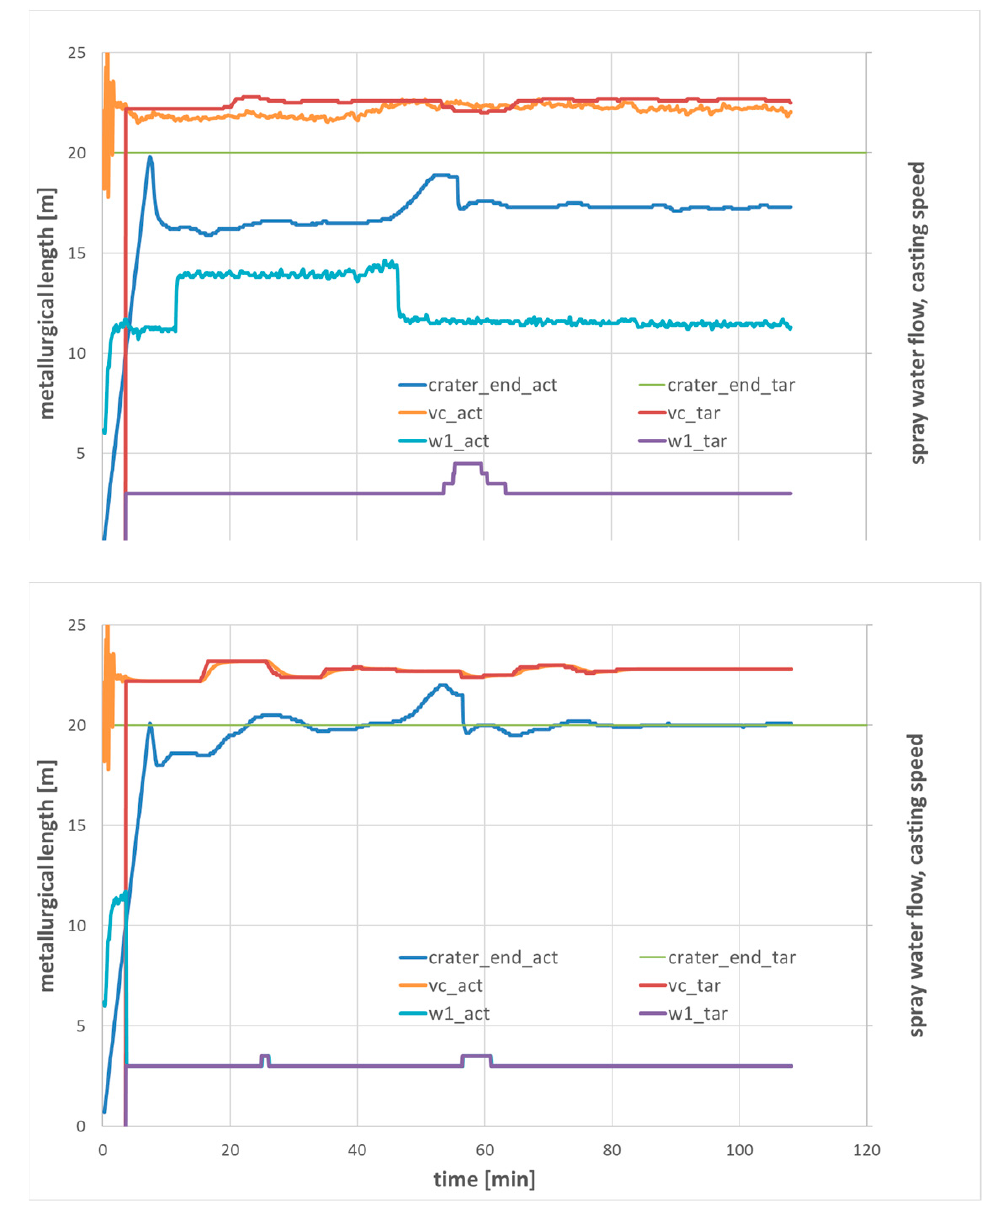
Figure 23. Evolution of actual and target casting speed, spray water flow and crater end position without ( top ) and with ( bottom ) application of target casting parameters for target crater end of 20 m at ESF billet caster.